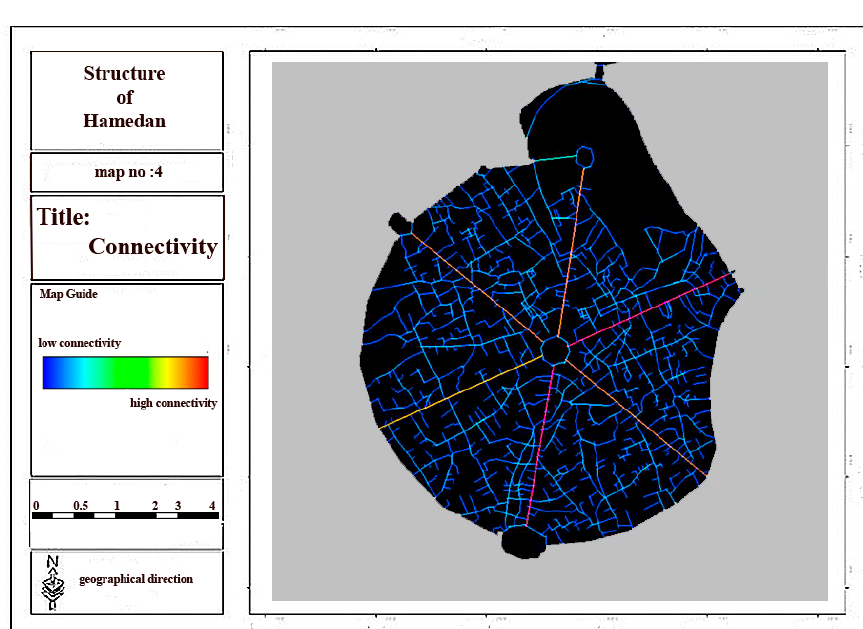
Figure 7. Connectivity in the main structure of city.